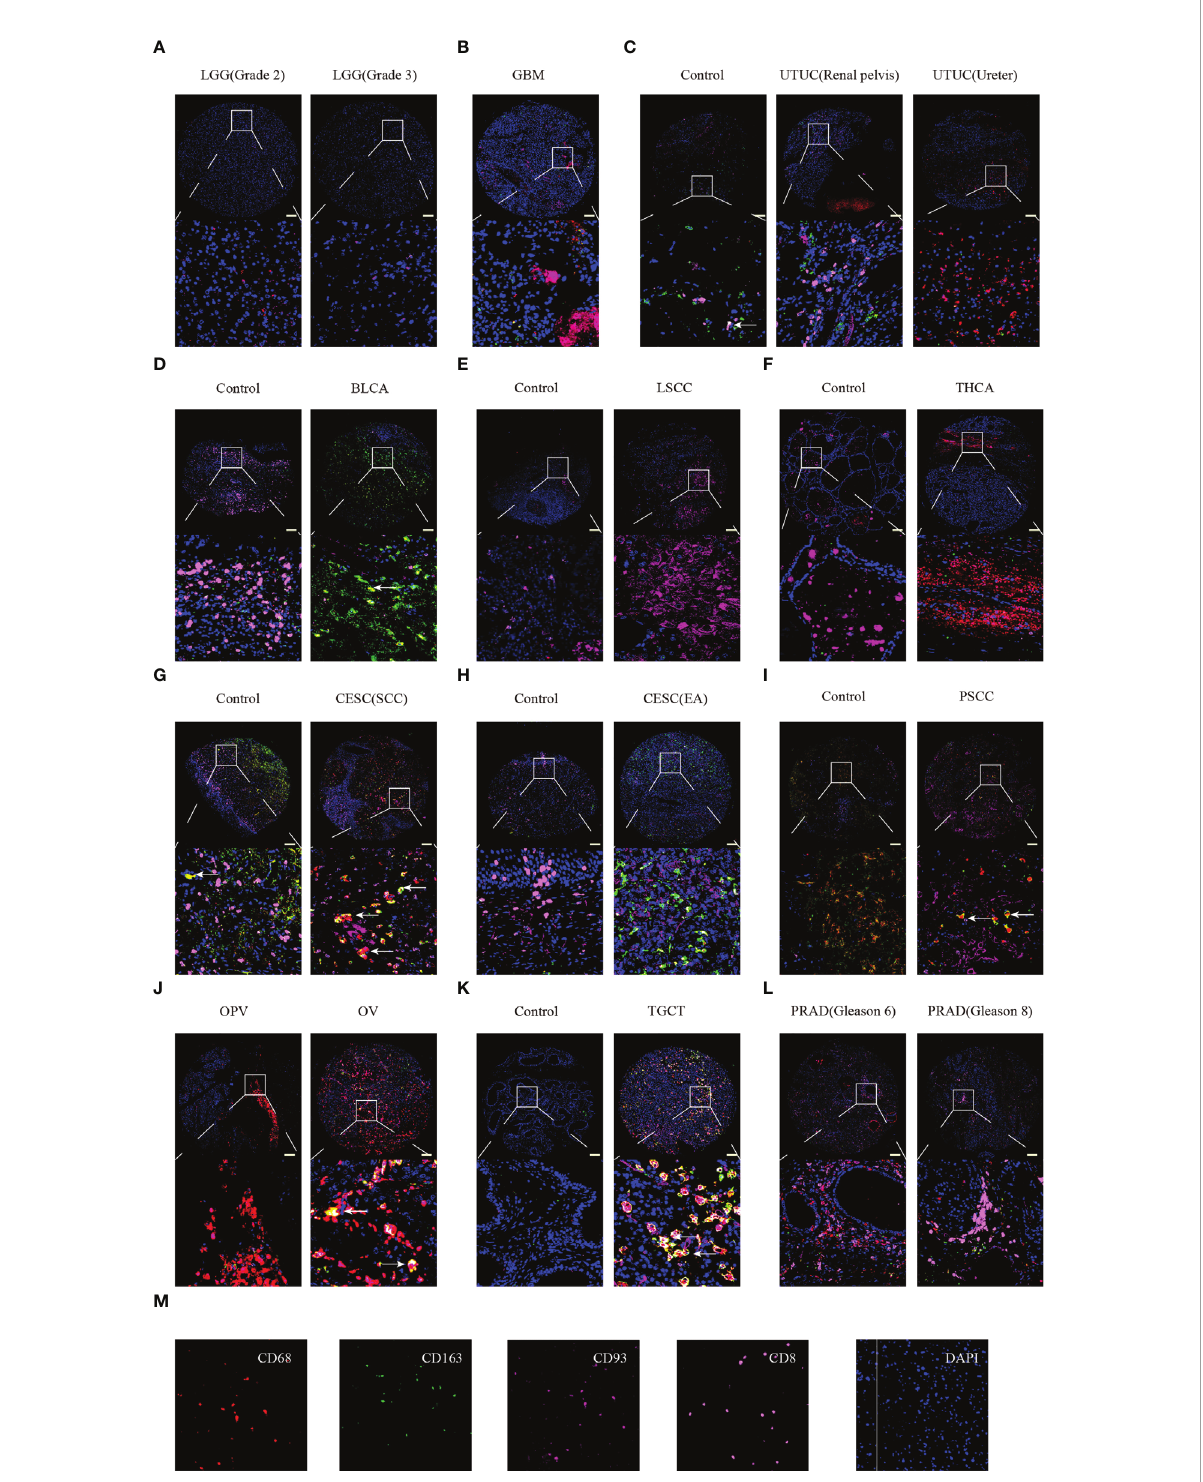
FIGURE 7 Multiplex immuno fl uorescence staining identi fi ed the relationship between CD93 expression and CD8, CD68, and CD163 in tumor and normal samples. LGG (A) , GBM (B) , UTUC (C) , BLCA (D) , LSCC (E) , THCA (F) , CESC (G, H) , PSCC (I) , OPV and OV (J) , TGCT (K) , and PRAD (L) . Staining for CD8, CD163, CD93, CD9, and DAPI (M) . Scale